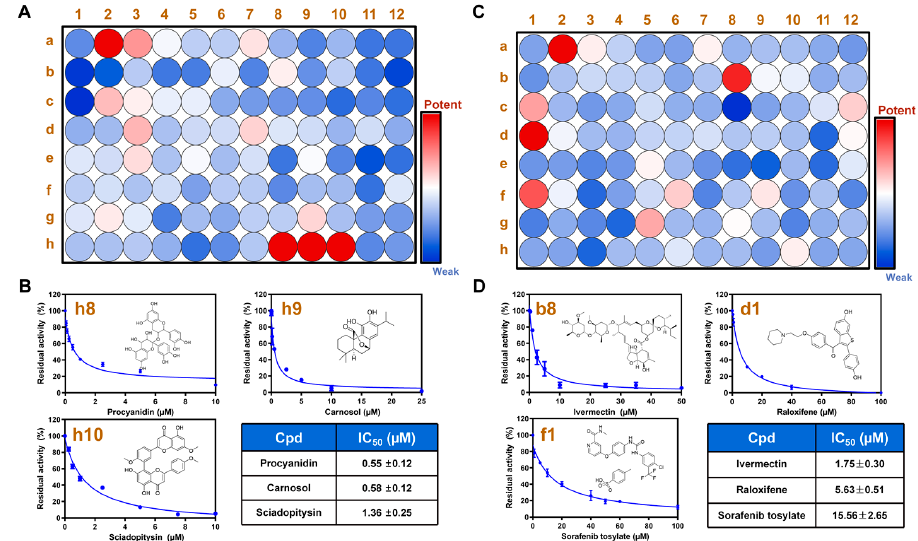
Figure 6. High-throughput screening of hPL inhibitors by RLE-based fluorescent assay. ( A ) Heat map for high-throughput screening of 94 natural products derived from herbs upon hPL inhibition. ( B ) Dose–inhibition curves of procyanidin (h8), carnosol (h9), and sciadopitysin (h10) against hPL-catalyzed RLE hydrolysis. ( C ) Heat map for high-throughput screening of 94 drugs upon hPL inhibition. ( D ) Dose–inhibition curves of ivermectin (b8), raloxifene (d1) and sorafenib tosylate (f1) against hPL-catalyzed RLE hydrolysis.